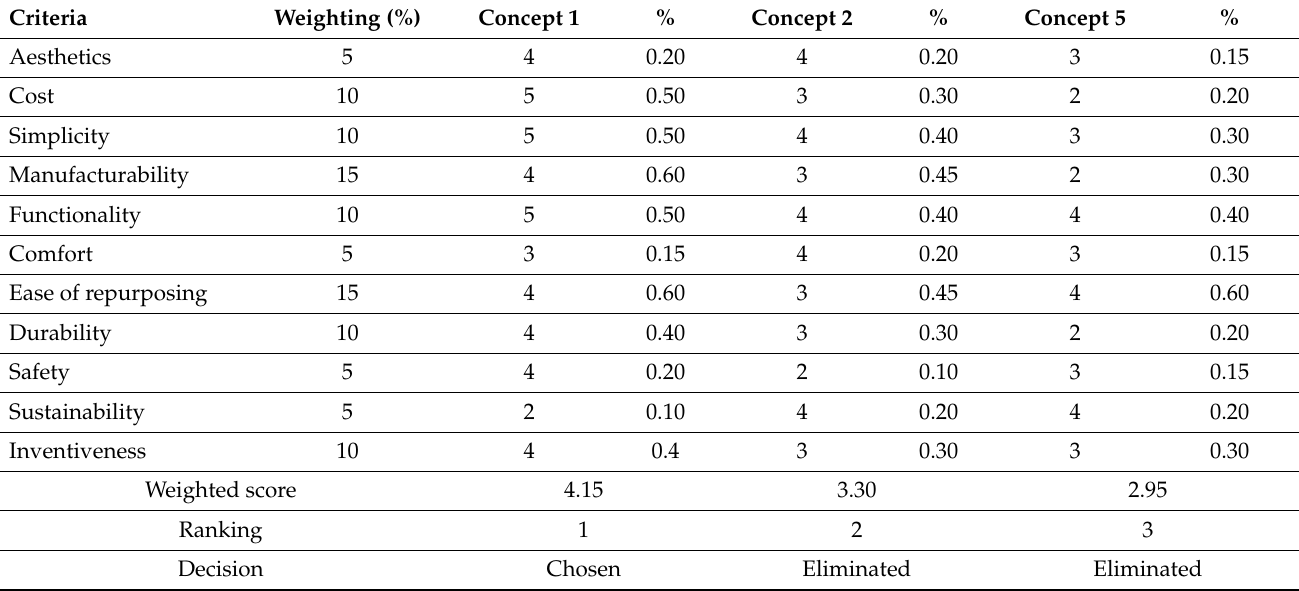
Table 5. Concept evaluation